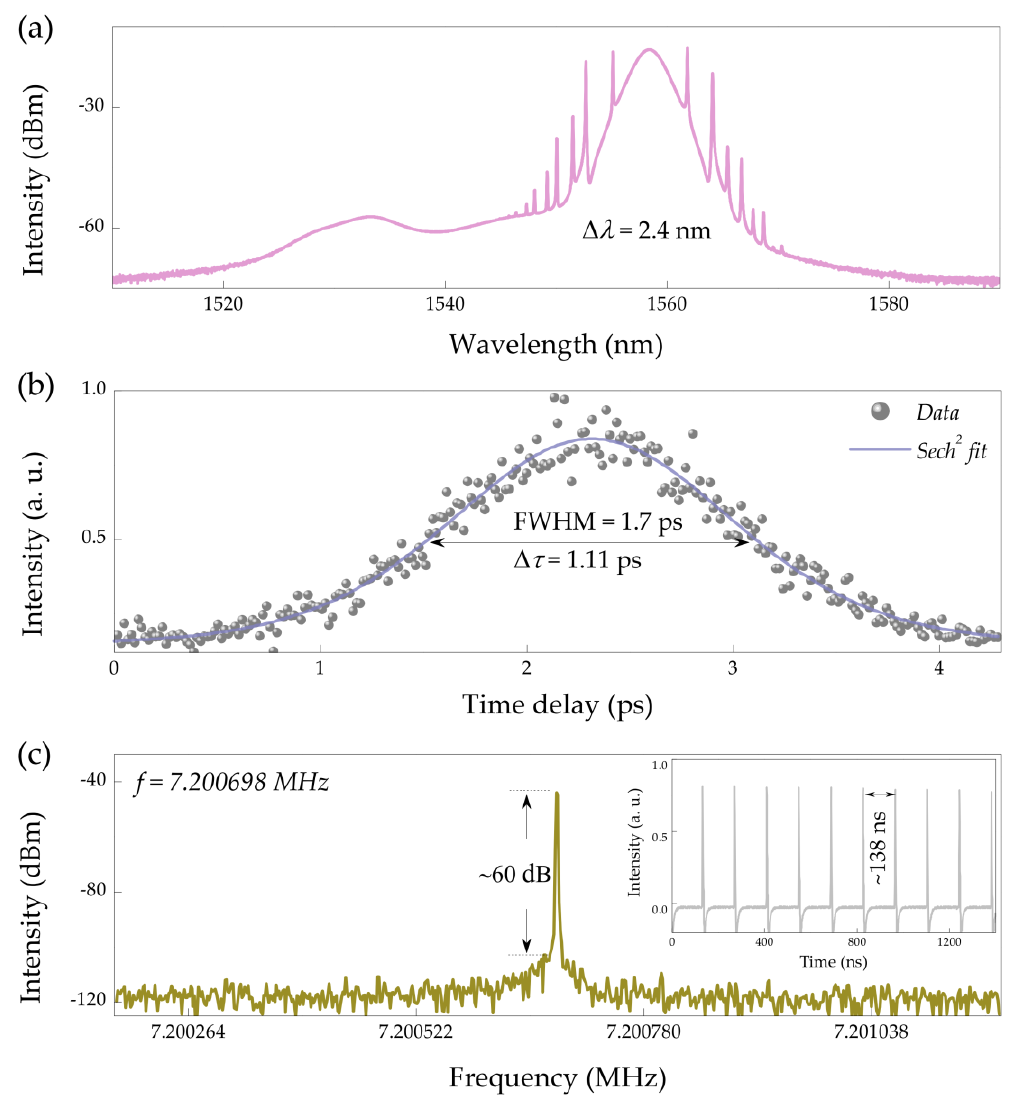
Figure 5. Single-wavelength conventional soliton. ( a ) Optical spectrum at 1559 nm, ( b ) autocorrelation trace, and ( c ) corresponding fundamental radio-frequency spectrum. Inset: pulse train.